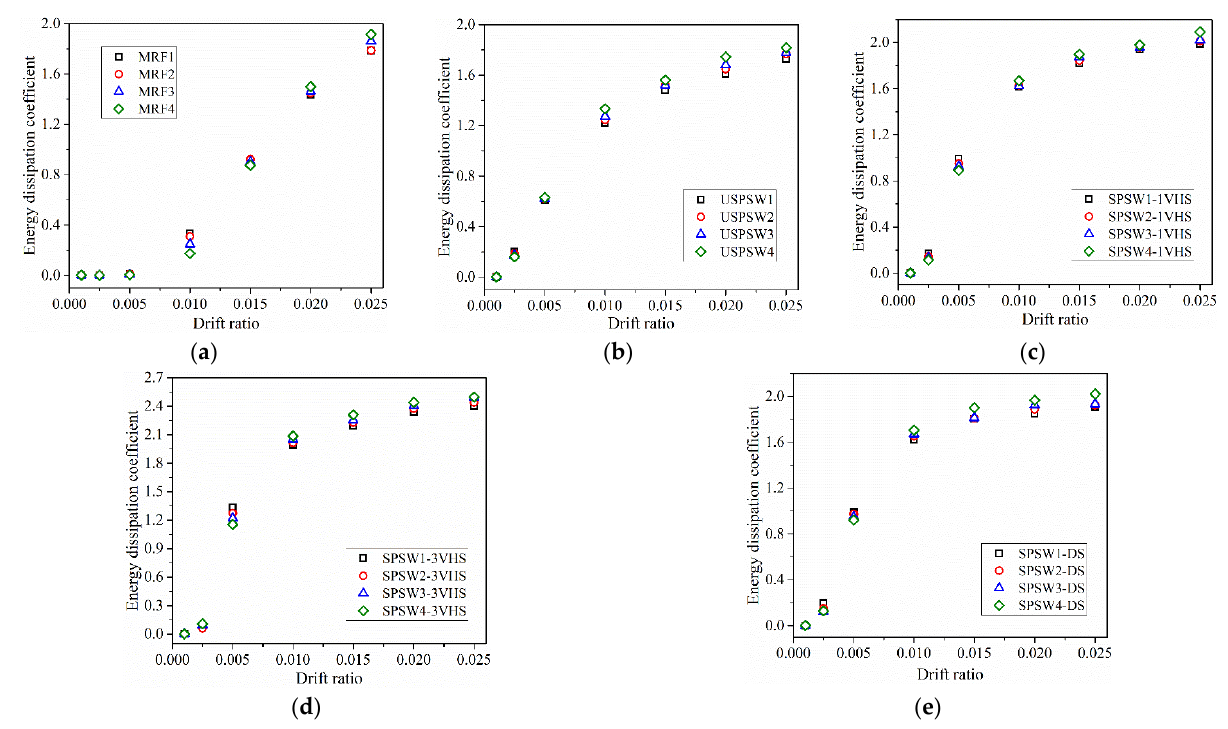
Figure 24. Energy dissipation coefficients of the ( a ) MRF, ( b ) USPSW, ( c ) SPSW − 1VHS, ( d ) Figure SPSW − 3VHS and ( e ) SSPSWs with variable column flexural stiffnesses. Table 7. Final energy dissipation results for MRF, USPSW, SPSW − 1VHS, SPSW − 3VHS, and SPSW − DS with variable column flexural stiffnesses.